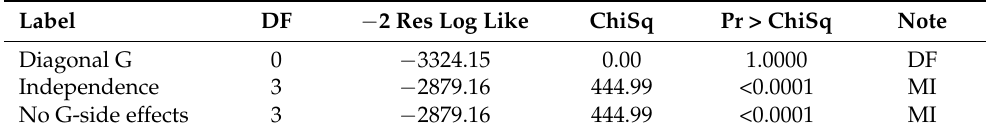
Table 3. Tests of Covariance Parameters Based on the residual Pseudo-Likelihood.